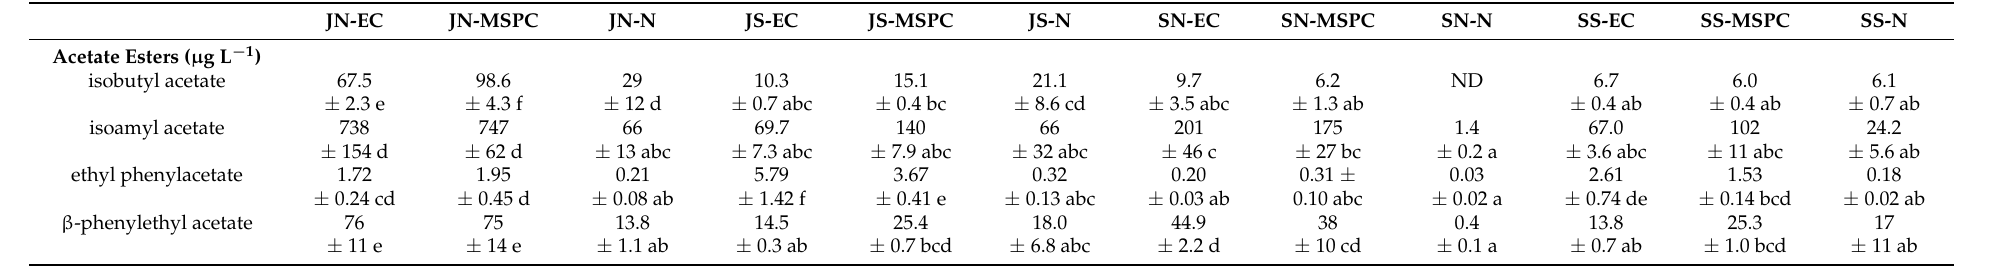
Table 3. Volatile compound concentrations in finished wines for each treatment. Mean ( n = 3) ± standard deviation. Mean values not connected by the same letter are significantly different (Tukey’s HSD, p < 0.05). Juice no skins (JN); juice plus skins (JS); SGM no skins (SN); SGM plus skins (SS); EC1118 (EC); MSPC community (MSPC); uninoculated (N); not detected